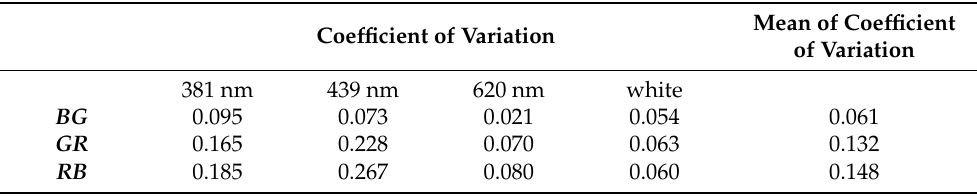
Table 2. Coefficient of variation of the color parameters BG , GR and RB